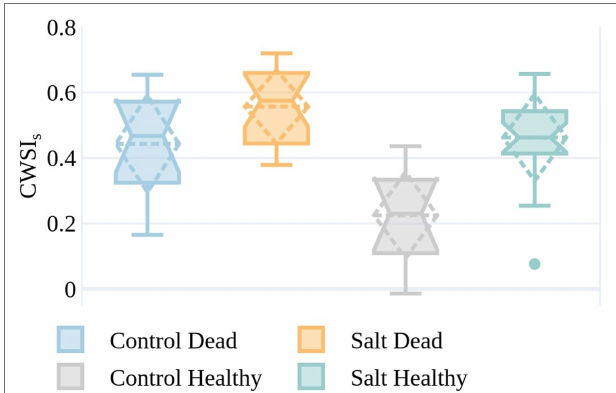
FIGURE 10 | CWSIs values on December 6 for the simplified statistical method for plants from both the control and salt-treated plots identified as either dead (by ground-based visual observation) on January 4 or healthy (by RGB image assessment) on January 7. The boxes span the interquartile range (IQR), with notches indicating the median and the dashed diamond the standard deviation and mean. The whiskers bound the 1.5*IQR. The sample size is reflective of the plants that were identifiable in the UAV imagery with the GRVI > 0 and plant temperature <air temperature +9 ° C on both December 6 and January 7, or field-identified as dead on January 4 (control dead = 12, control healthy = 10, salt dead = 18, and salt healthy =